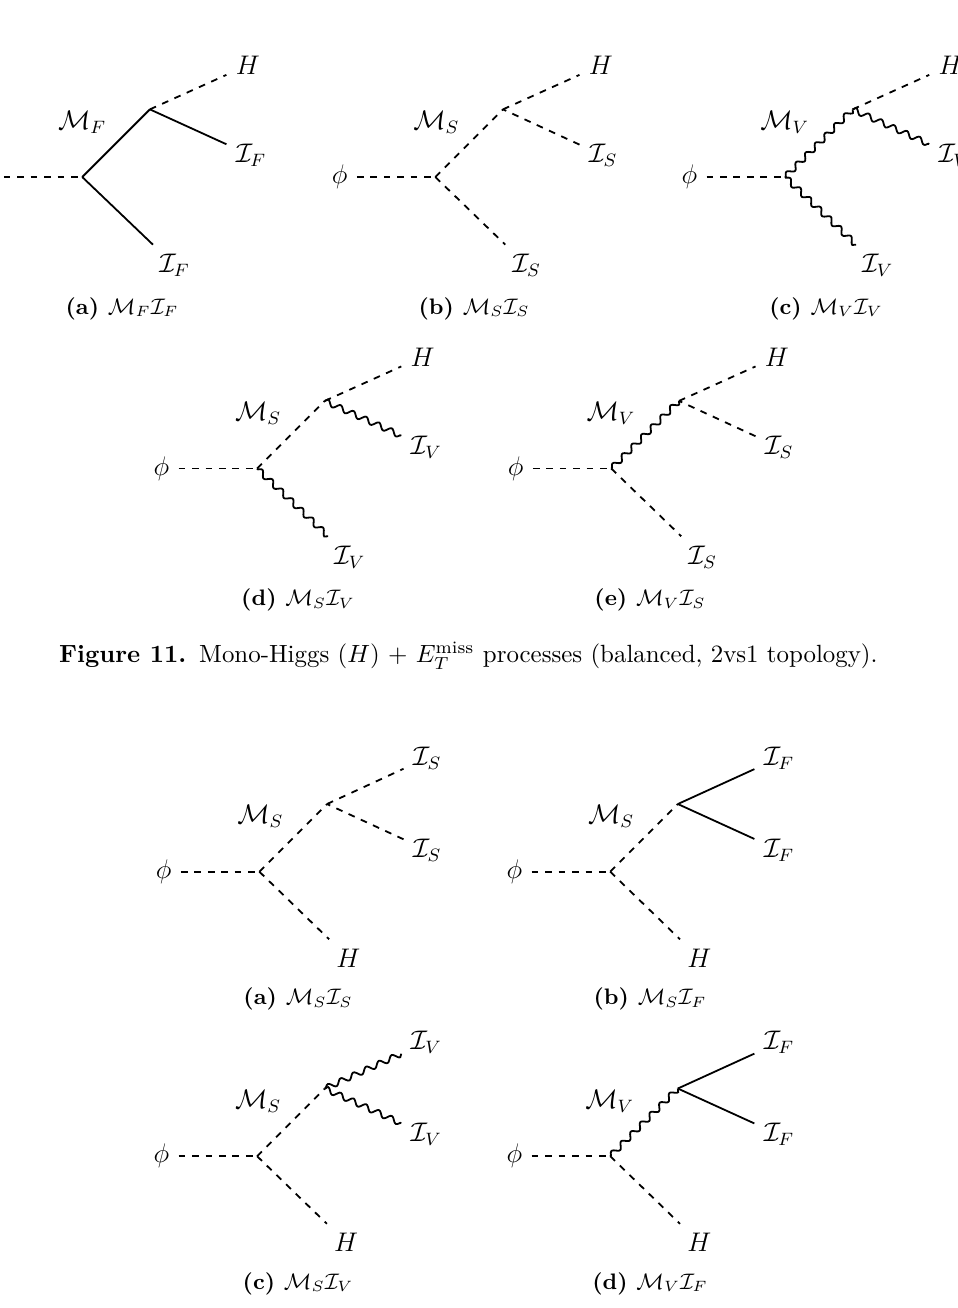
processes (unbalanced, 2vs1 T